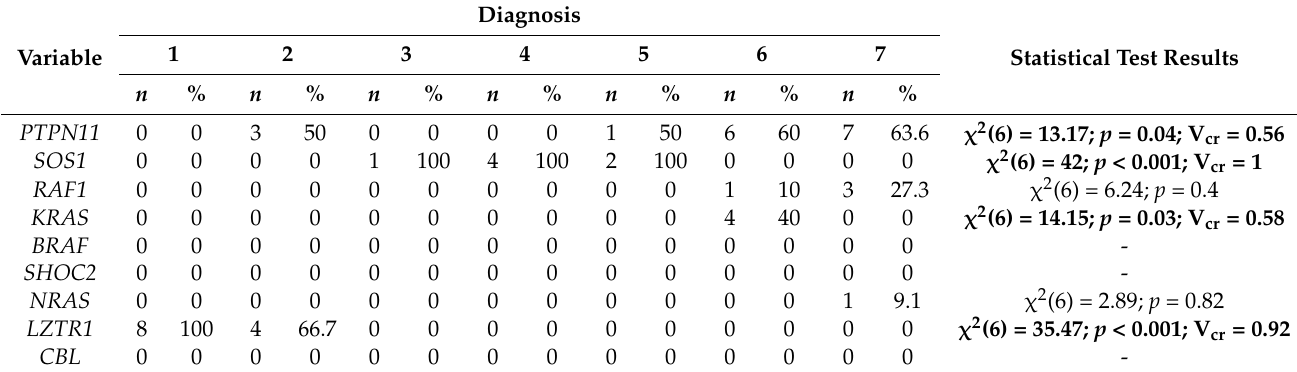
Table 5. Incidence of individual genetic parameters in the studied group, divided according to clinical diagnosis.